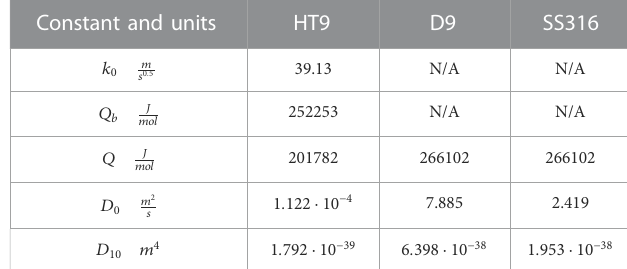
TABLE 2 Wastage constants and